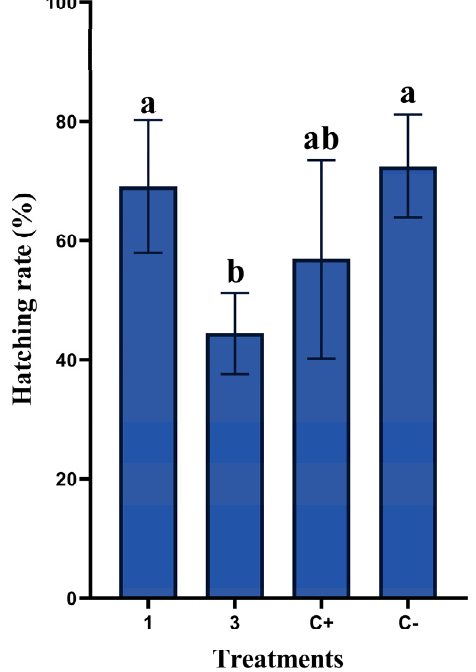
Figure 1. Effects of in ovo administration of different concentrations of rosemary EO on hatchability rates in non-injected eggs (C − ), positive control injected with distilled water (C+), and eggs injected with rosemary EO at 1 or 3 µ L/egg (five replicates/group). Different letters (a, b) indicate a statistically significant difference ( p < 0.05). Values are represented as mean ± standard error of the mean (SE).